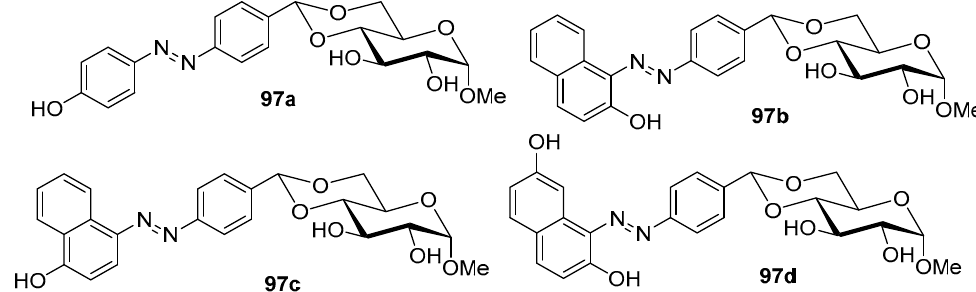
Figure 57. Structures of sugar azobenzene-derived LMWGs [112].